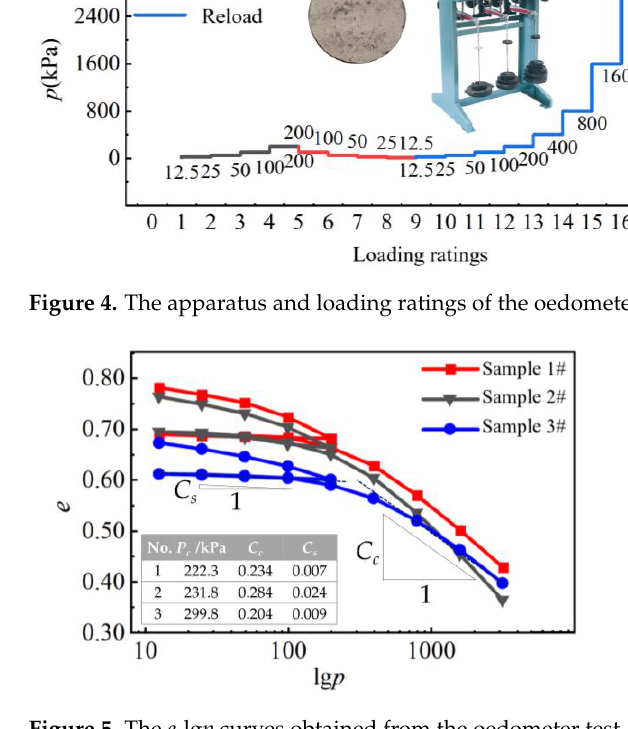
Table 1. Physical and mechanical parameters of silt for the